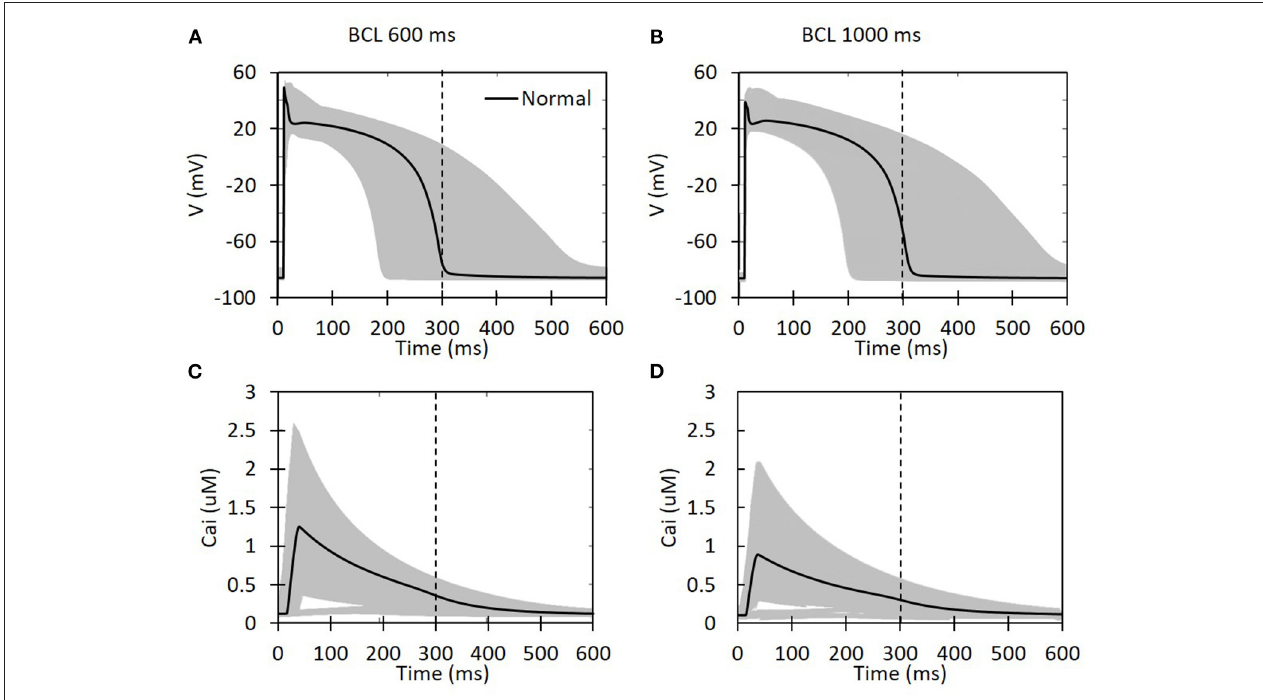
FIGURE 2 | The action potential shape and intracellular calcium transient for all possible ion channel maximum conductance variations. The x-axis is time in milliseconds for all the panels. For (A,B) , the y-axis is the membrane potential in millivolt, and, for (C,D) , it is the intracellular calcium concentration in micromolar. The black solid line represents a case with normal maximum conductance for each ion channel (set to its 100% value). The vertical dashed line indicates 300 ms.